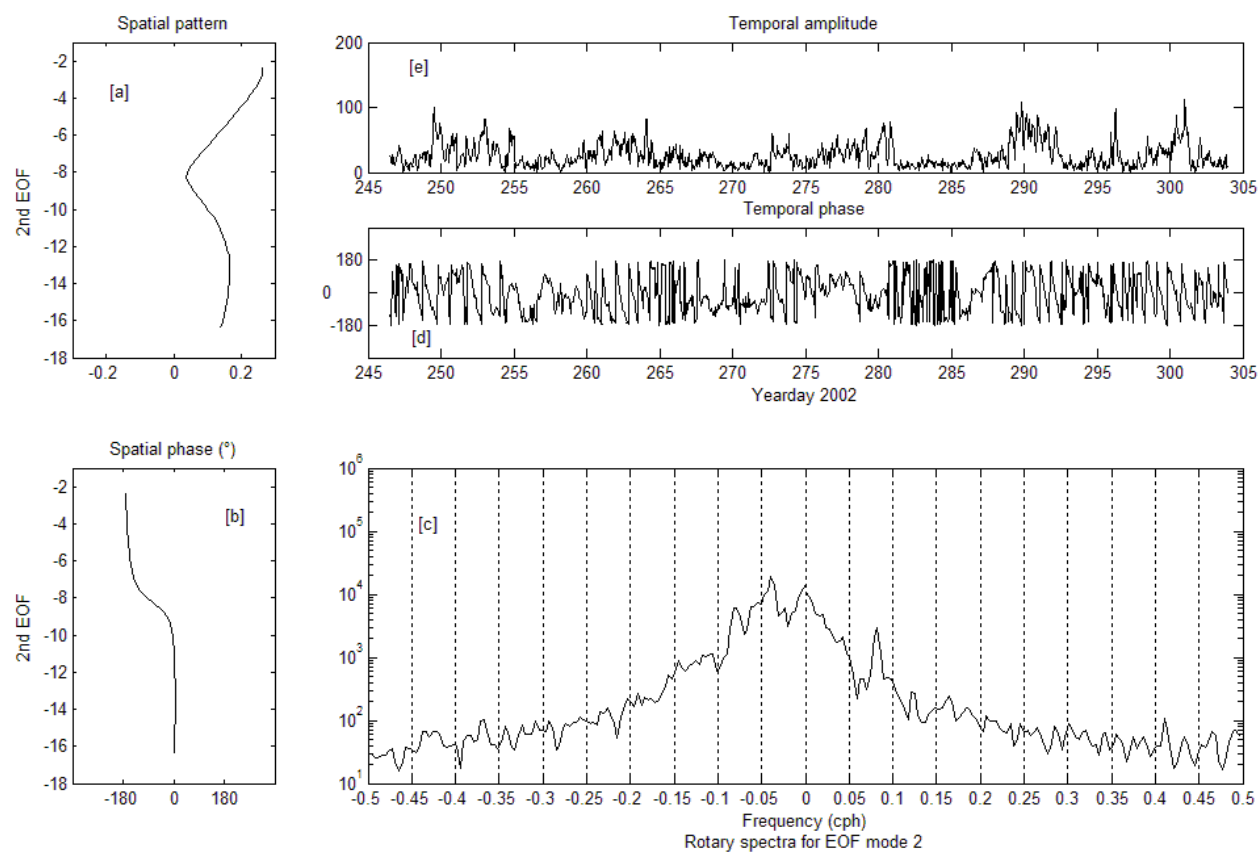
Fig. 10. Interpretation of the second EOF mode derived from the analysis of ADCP time series of current profiles at the Oceanographic Tower for the period September–October 2002. In a clockwise sense from the upper-left corner, the panels read as follows: (a) Spatial pattern showing the vertical structure for the first EOF mode along the water column; (b) Spatial phase showing information on phase lag form top to bottom of the water column. The spatial pattern is non-dimensional, while units for the spatial phase are degrees. Units for the vertical axis are m. (c) Two-sided rotary spectrum for the expansion coefficients associated to the EOF modes, partitioning variance into dominant time scales. Units for the y-axis are (cm/s) 2 /cph. (d) , (e) Time series of temporal phase angle and expansion coefficients, showing the time evolution of the spatial pattern over time. Units for the spatial phase angle are degrees; units for the expansion coefficients are